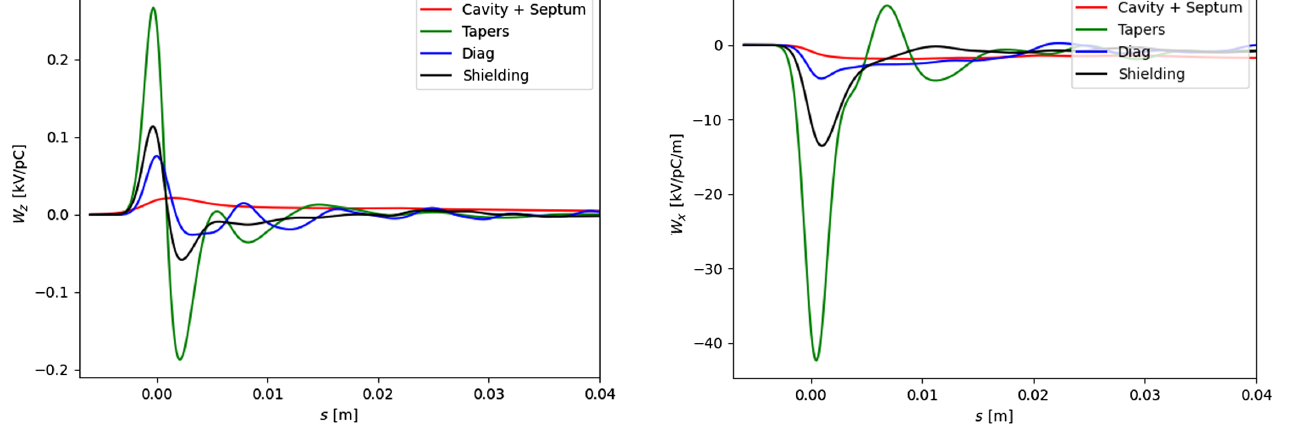
FIG. 15. Longitudinal geometric wake potential. FIG. 16. Horizontal geometric dipolar wake